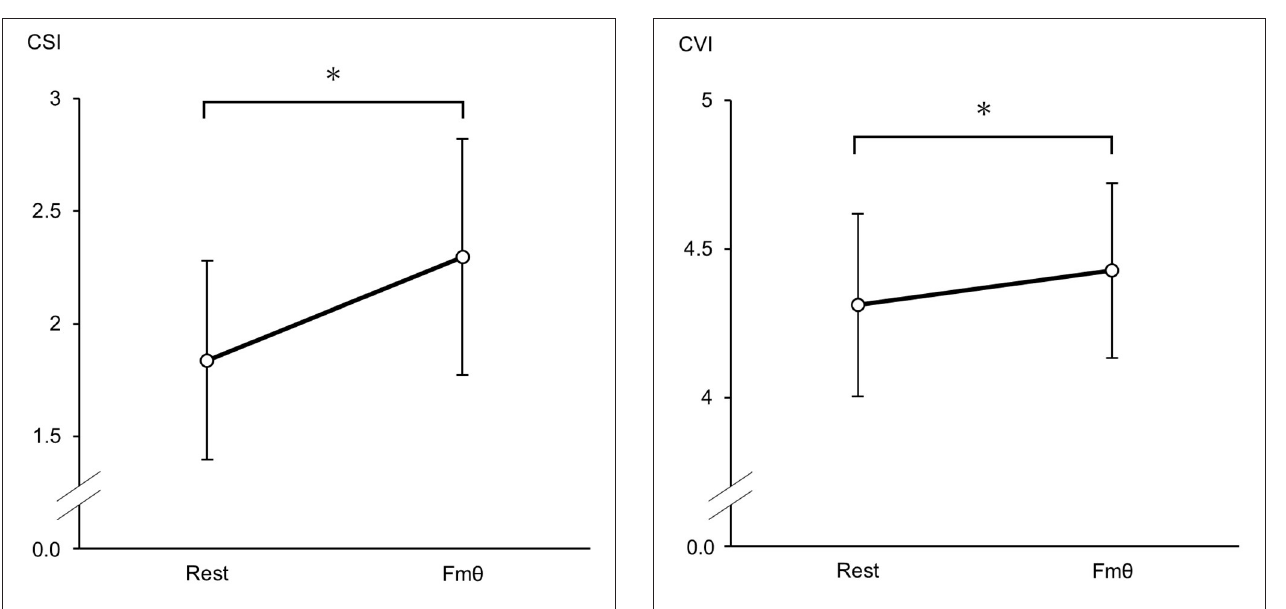
TABLE 1 | Correlations between serum Fm θ power, Fm θ number of appearance and cardiac autonomic